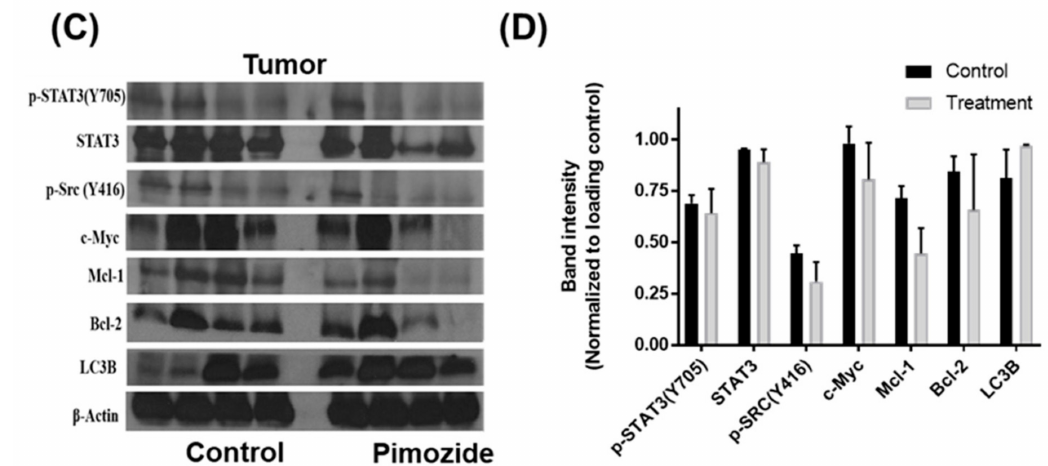
Figure 9. Pimozide suppresses the growth of intracranially implanted brain tumor cells. ( A ) About 0.15 × 10 6 U-87MG luc cells were implanted intracranially in the brain of 4–6-week-old athymic nude mice. Mice were treated with 25 mg / kg pimozide starting day 14 after tumor cells were implanted until day 60. Representative luminescence (photons / second) was measured about thrice a week and plotted against days. The statistical significance level was considered as * P ≤ 0.05. ( B ) Representative mouse brain from the control and pimozide-treated groups after terminating the experiment. ( C ) After terminating the experiment, brains with tumors were removed aseptically, lysed, and analyzed for p-STAT3, STAT3, p-src, Mcl-1, Bcl-2, and LC3B. ( D ) Graphical representation of the protein expression in control and treatment groups when normalized with its respective β -actin.